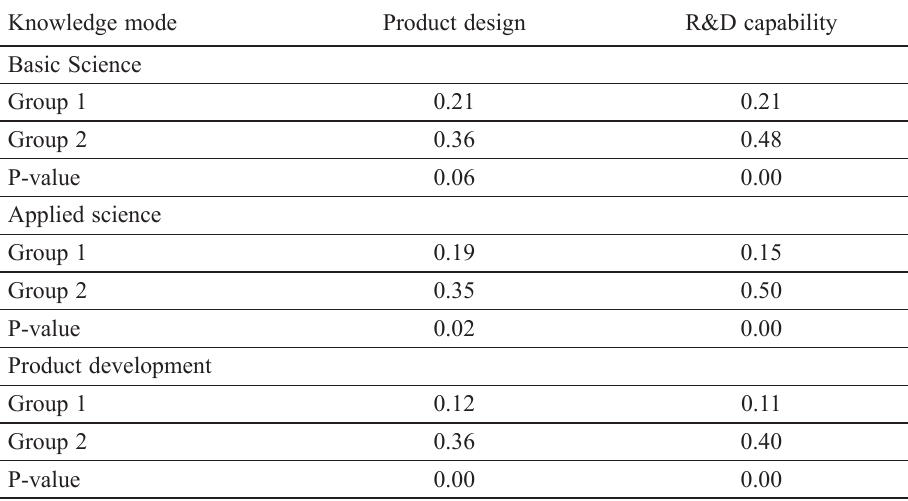
Table 4. T-tests of intra-firm